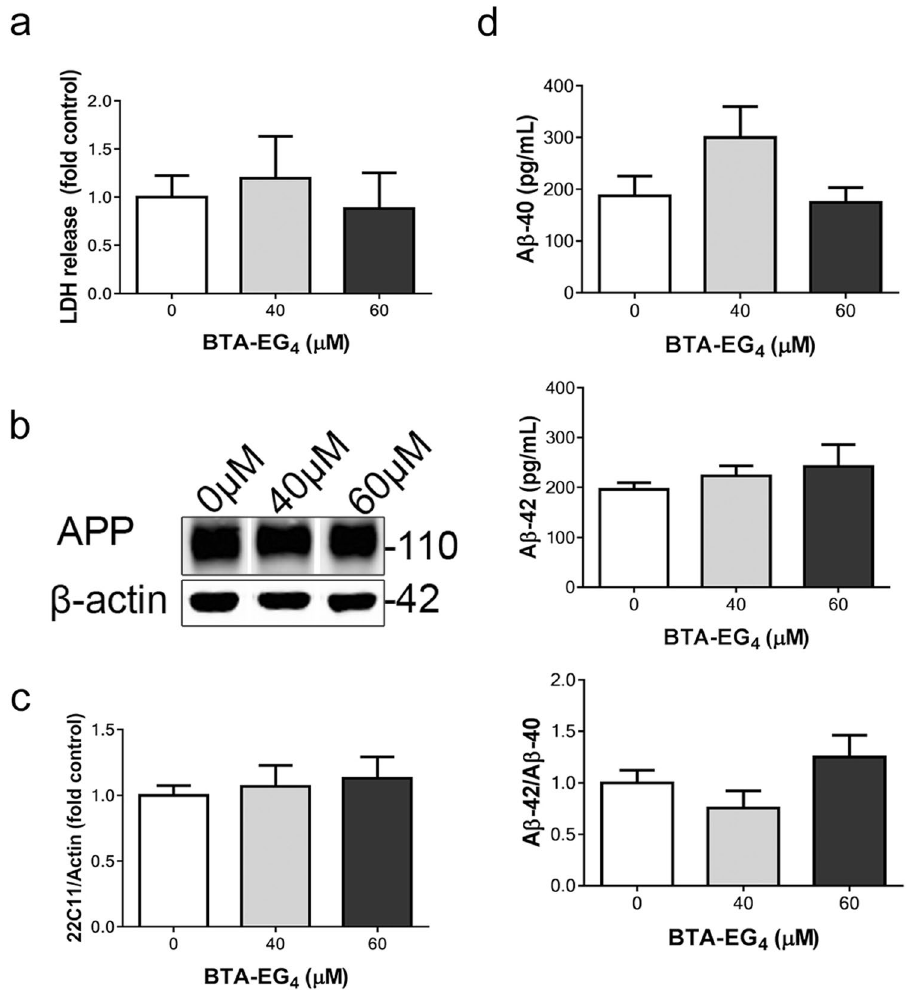
Figure 2. BTA-EG 4 treatment of 3xTg-AD brain slice cultures does not alter APP processing, amyloid load or cell viability. ( a ) Bar chart shows the proportion of LDH released as a proportion of total LDH following treatment of 3xTg-AD slice cultures with control (DMSO, 0 μ M), 40 μ M or 60 μ M BTA-EG 4 for 48 h. Data is mean ± SEM and is shown as fold change from control. n = 12. ( b ) Representative western blots of lysates prepared from 3xTg-AD slice cultures treated with 40–60 μ M BTA-EG 4 and control (DMSO, 0 μ M) for 48 h probed with an antibody against N-terminal APP (22C11) and β -actin as a loading control. ( b ) Bar chart shows amounts of total APP relative to β -actin amounts in the same sample. n = 12. Data is mean ± SEM and is shown as fold change from control. ( c ) Amounts of A β -40 and A β -42 were measured in BTA-EG 4 -treated slice cultures using specific A β -40 and A β -42 ELISAs. Bar charts show amounts of A β -42 and A β -40. Data are shown in pg/ mL. The ratio of A β -42 relative to A β -40 is also shown. Data is mean ± SEM and are shown as fold control. n = 4. All data analysed by one-way ANOVA with post-hoc Dunnett’s multiple comparisons